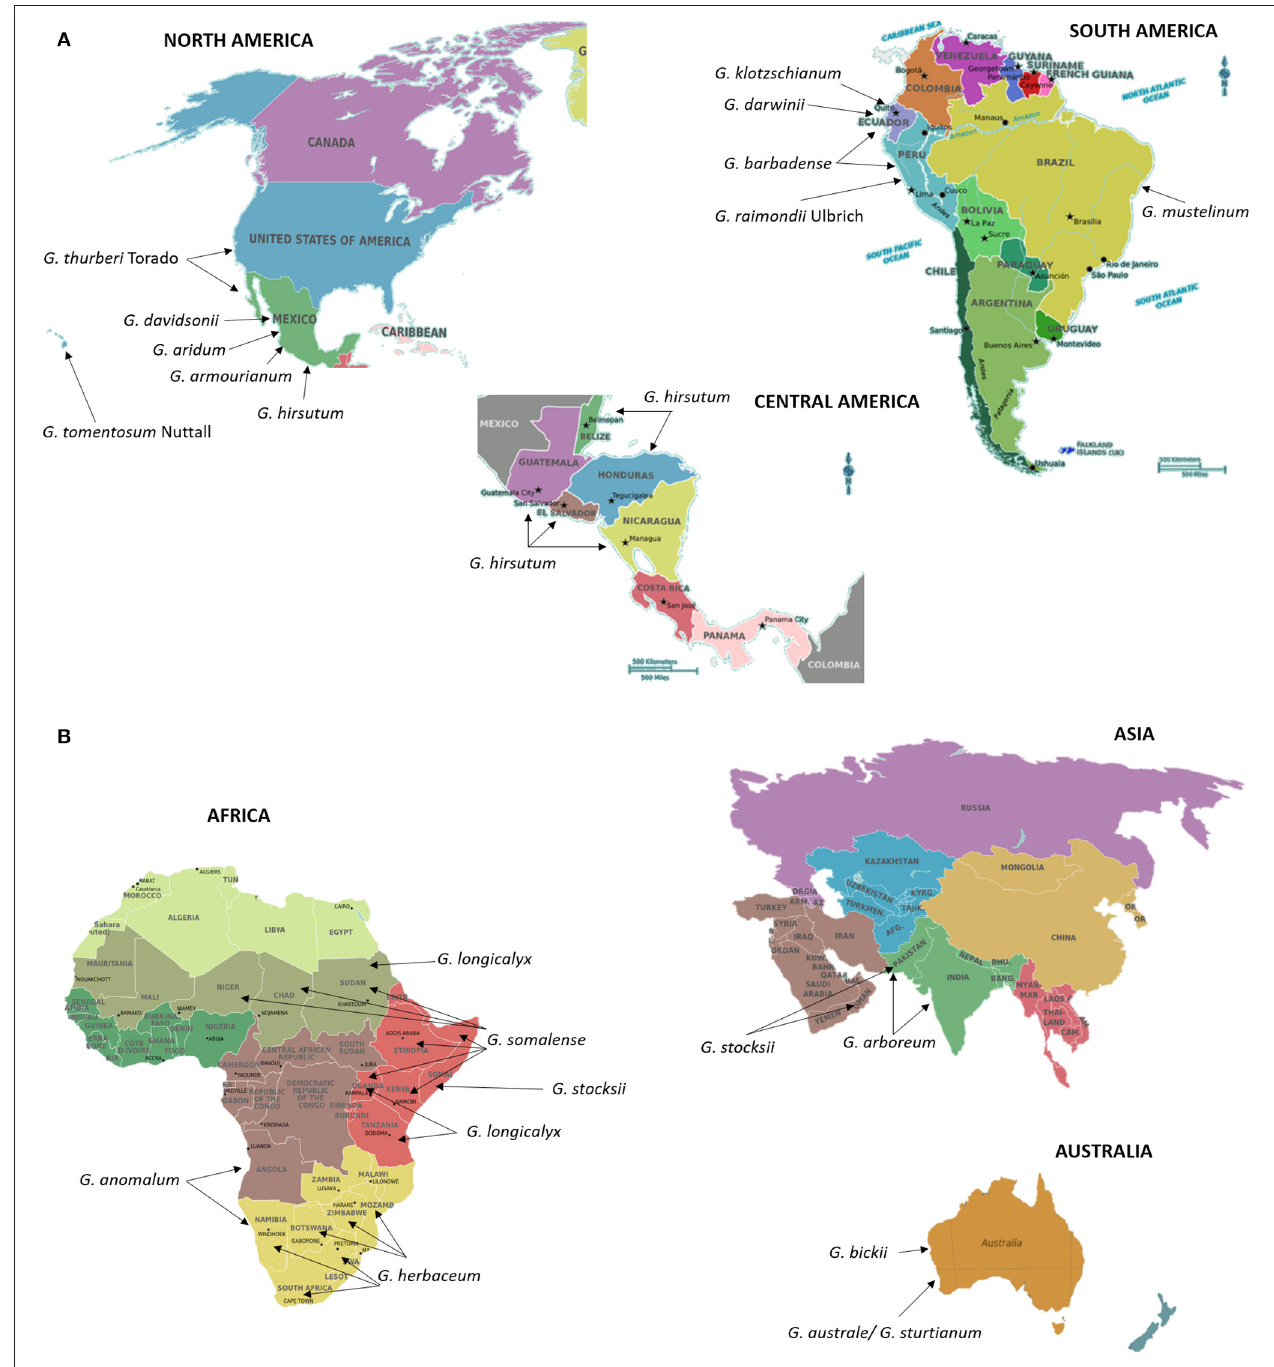
FIGURE 3 | (AB) Centers of origin or primary geographic distribution sites of cultivated cotton species G. hirsutum L. (A) , G. barbadense L (A) , G. arboreum L. (B) , and G. herbaceum L. (B) , and their wild relatives (A,B) . Information on the distribution and centers of origin was gathered from Fryxell (1992) and Wendel and Cronn (2003). Seeds of cotton and its wild relatives are stored and could be obtained from the Germplasm Resources Information Network in Beltsville, USA (https://